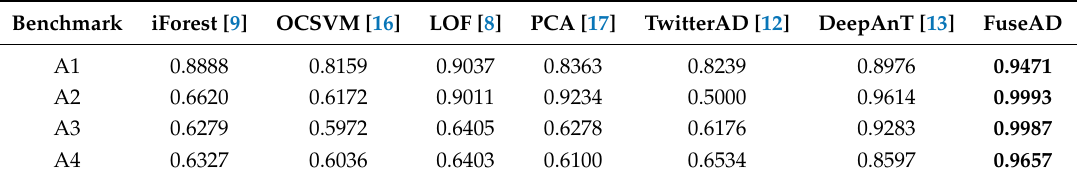
Figure 5. Zoomed-in plots of two out of three anomalies detected in Figure 4. It shows that FuseAD is capable of correctly detecting point anomalies in streaming data where traditional anomaly detection methods fail normally. Table 1. Comparative evaluation of state-of-the-art anomaly detection methods on the Yahoo Webscope dataset. Average AUC per sub-benchmark is shown in this